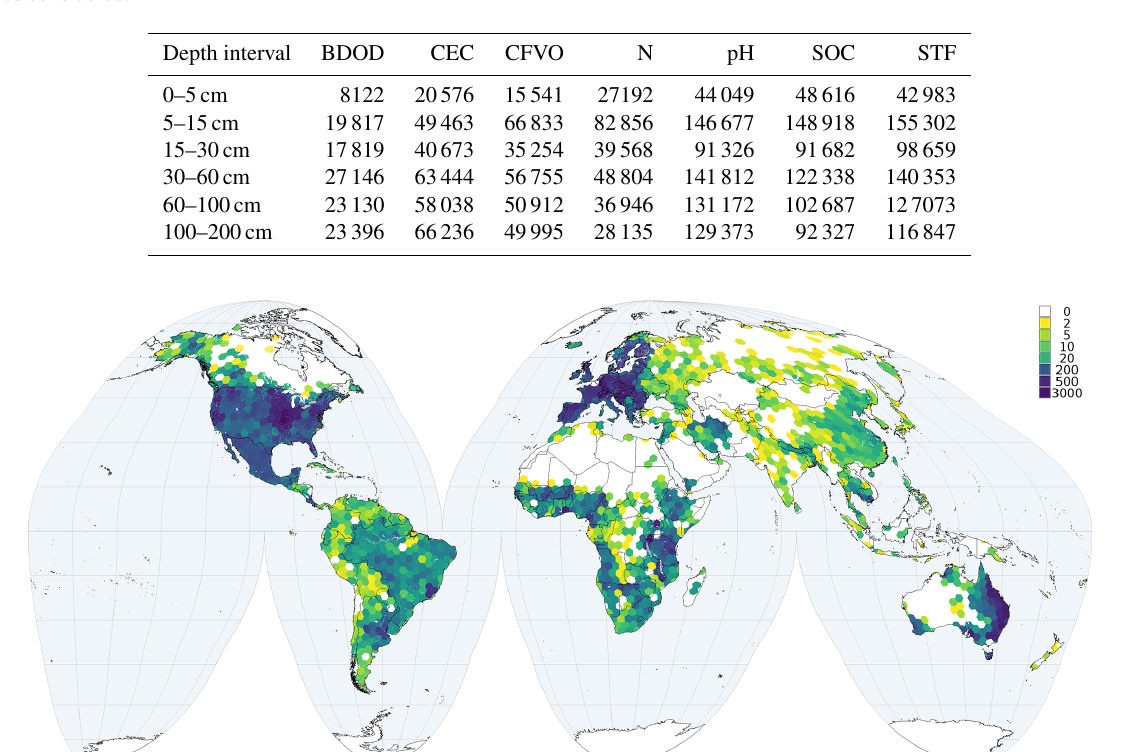
Table 2. Number of observations per standard depth interval for each soil property. See Table 1 for abbreviations and units of the soil properties considered.